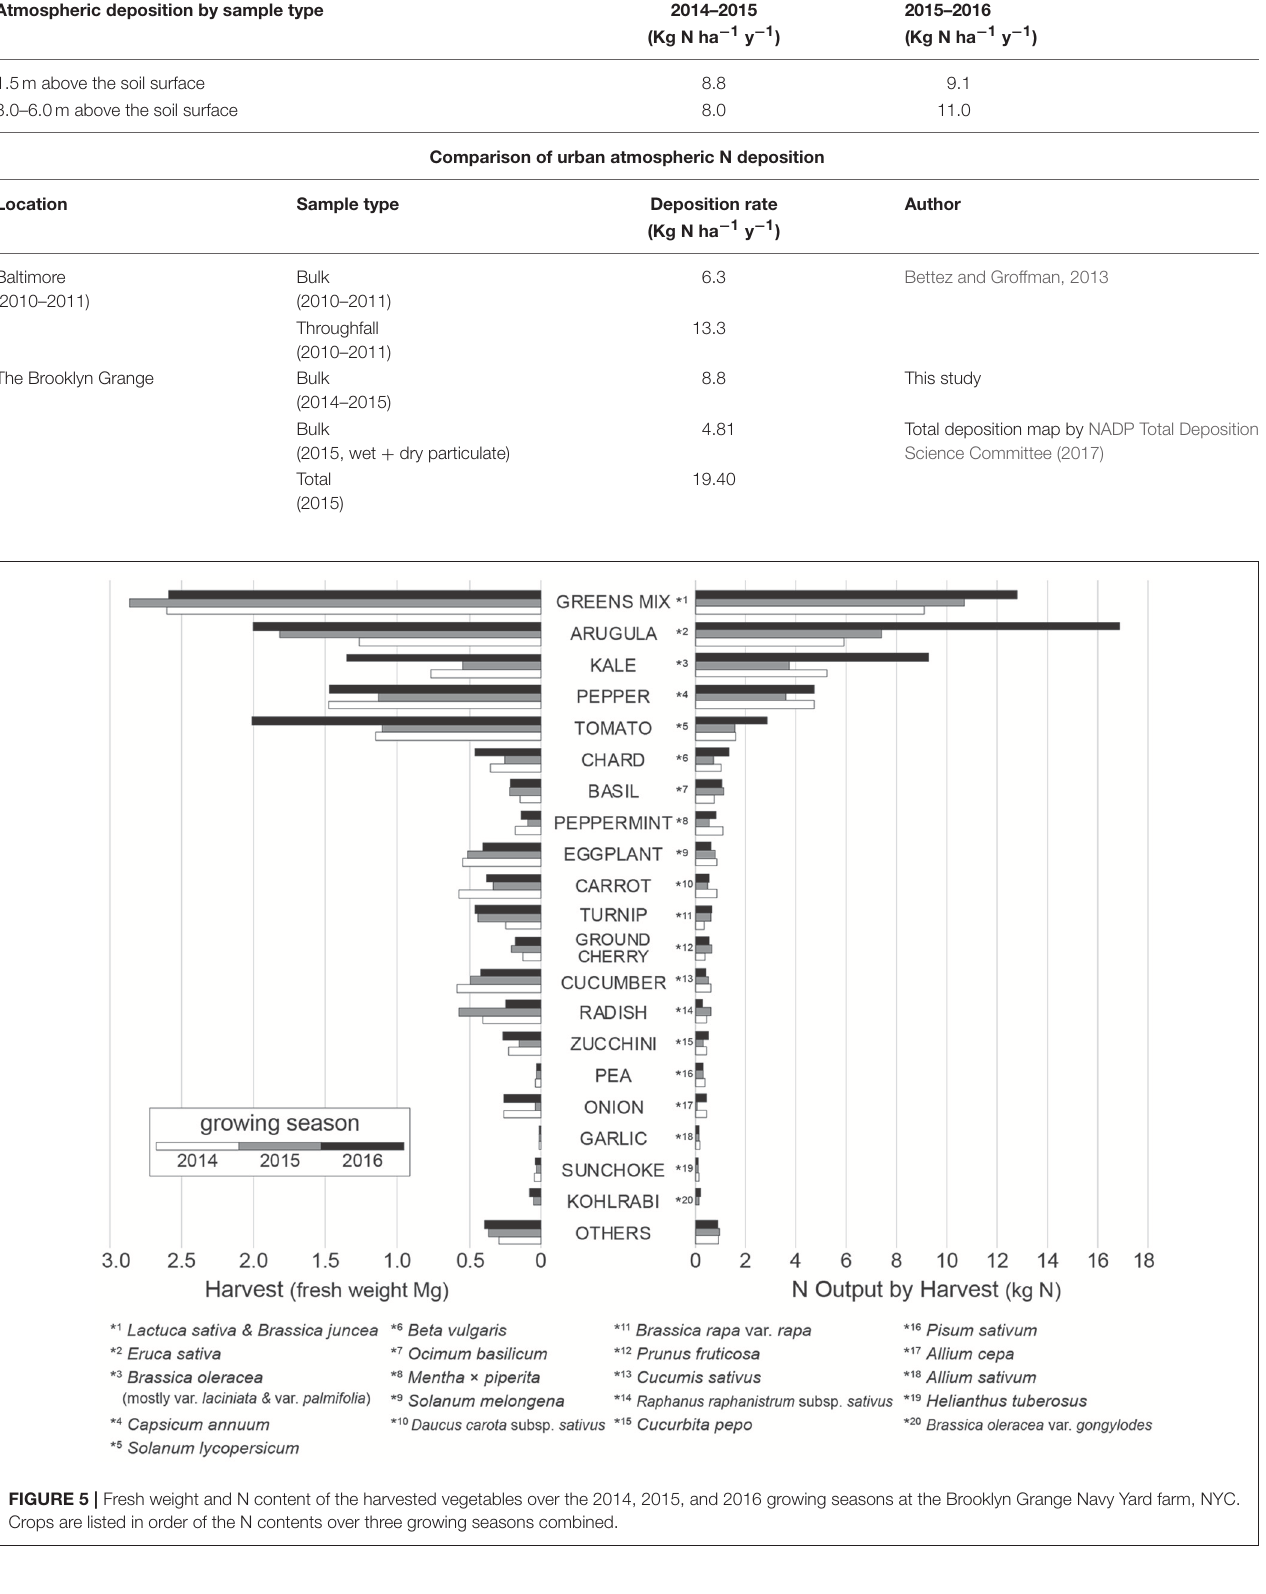
Frontiers in Ecology and Evolution |